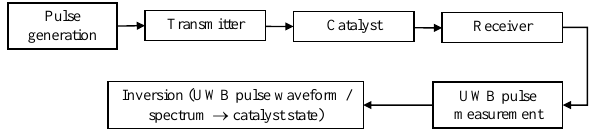
Table 1. Soot load of the measured DPFs (Fischerauer et al., 2010a).